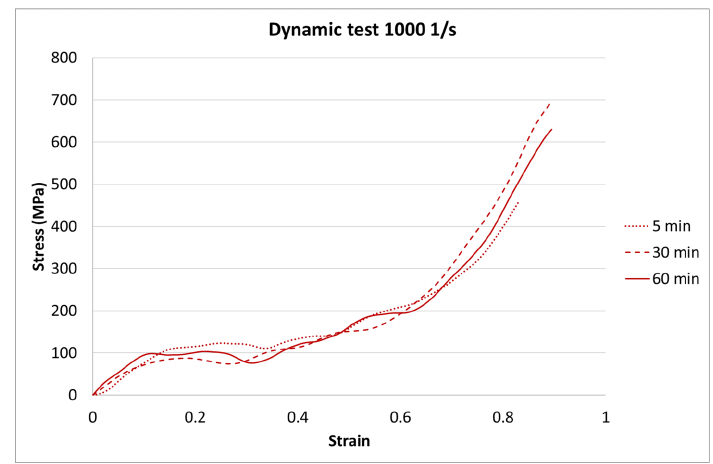
Figure 12. Results of the dynamic test (strain rate of 1000 1/s) of durable resin for curing times of 5, 30, and 60 min for UV and heat exposure. Materials 2020 , 13 , x FOR PEER REVIEW